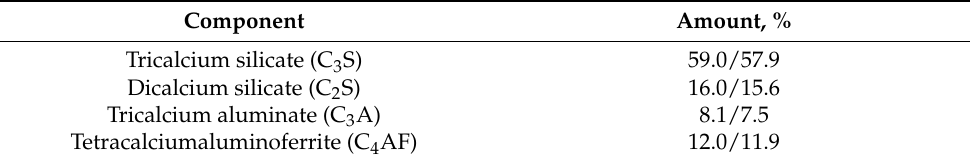
Table 1. Mineral composition of cement.